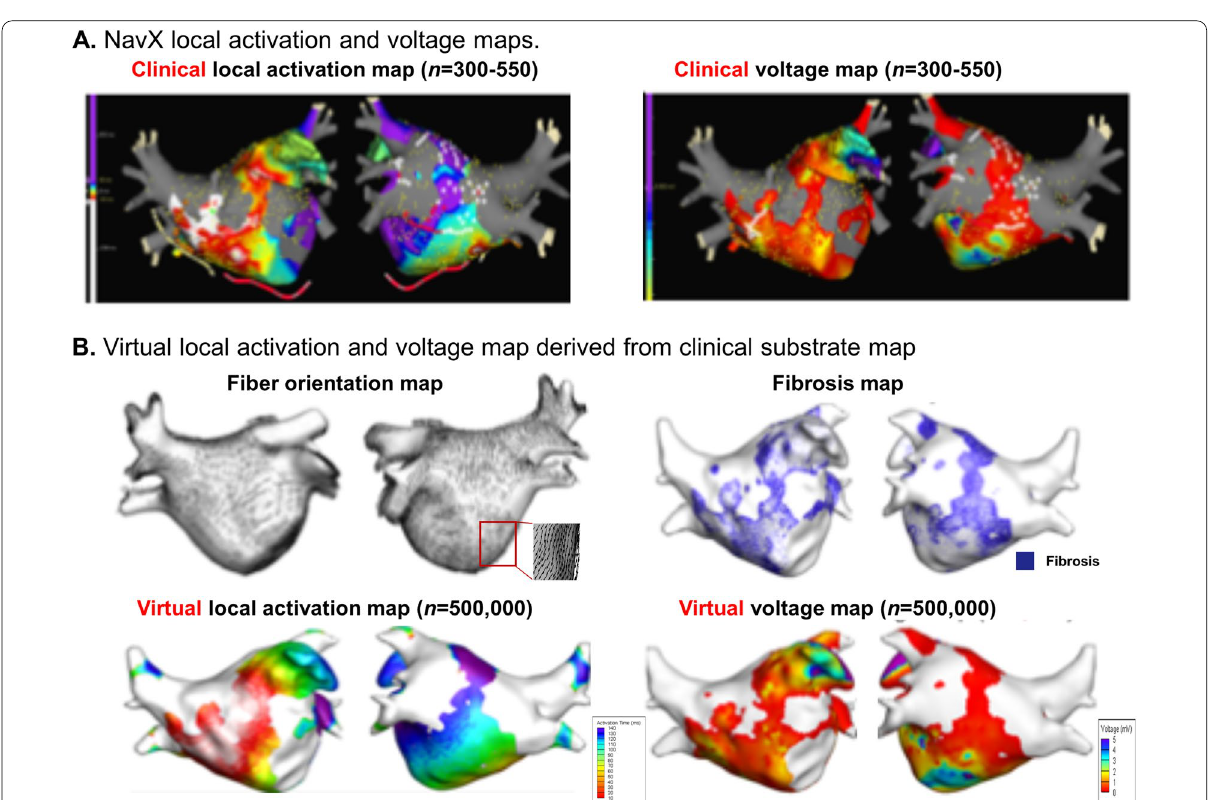
Fig. 3 High‑resolution virtual local activation and voltage maps derived from clinical substrate maps are quantitatively compared with low‑resolution clinical local activation and voltage maps. A A clinical substrate map consisting of local activation and voltage maps was acquired by the NavX system. B Virtual local activation and voltage maps for virtual atrial remodeling are derived from clinical substrate